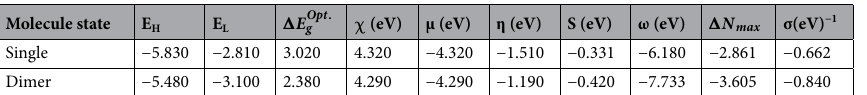
Table 3. The calculated E H , E L , energy gap ( E electronegativity ( χ ), global softness (S), and global electrophilicity index (ω) for [ThiPy-3,8-Dc] as a dimer and a single